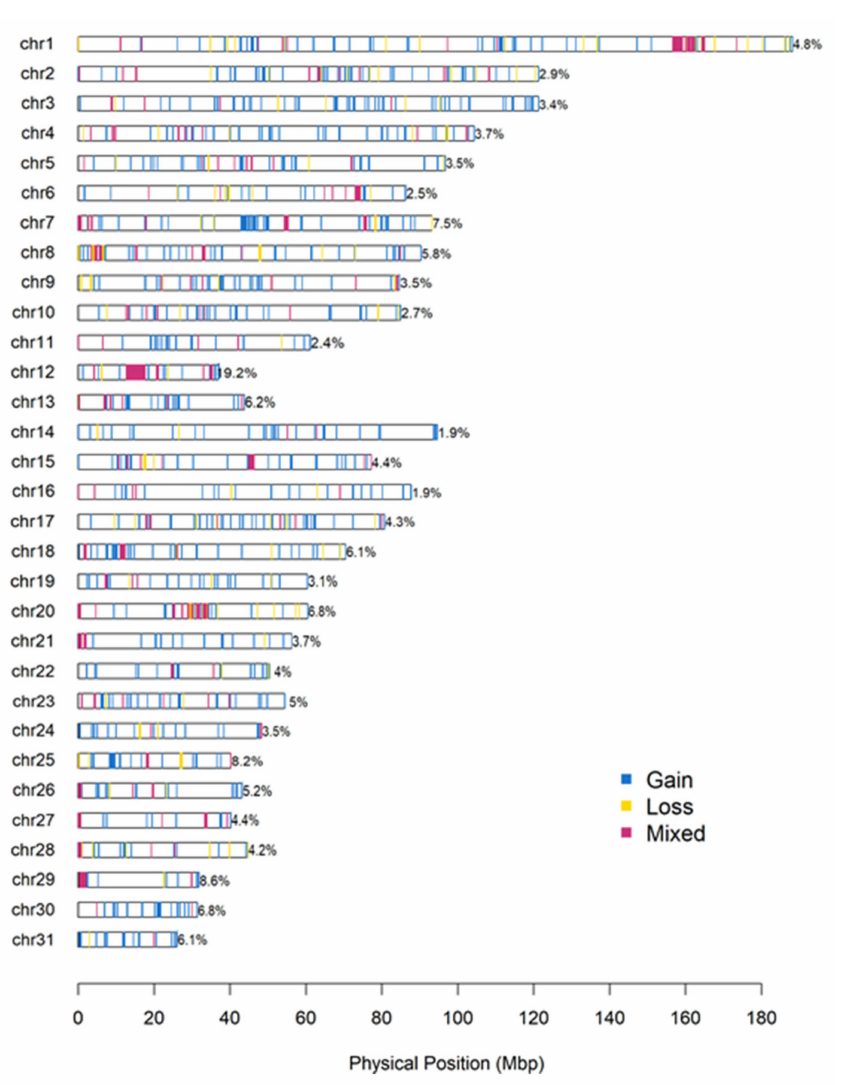
Figure 2. Map of CNVRs in the 31 equine autosome chromosomes. Blue, yellow, and red represent gain, loss, and mixed,